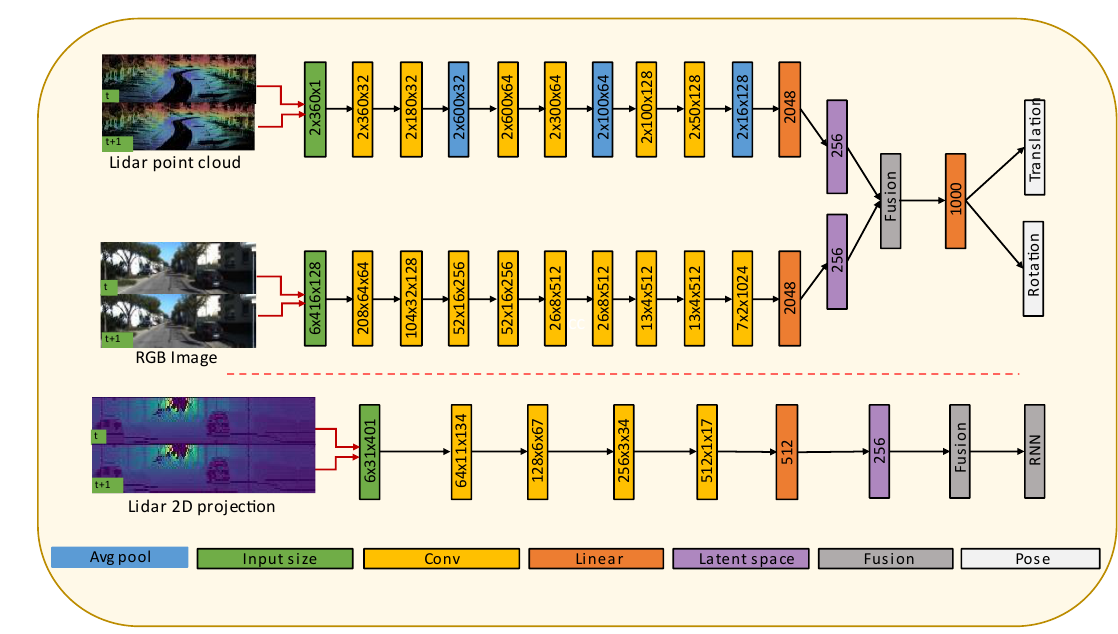
Figure 5. Architectures for fusion of camera and LiDAR point cloud data (upper part), and fusion of camera and LiDAR data projected in 2D images (lower part).